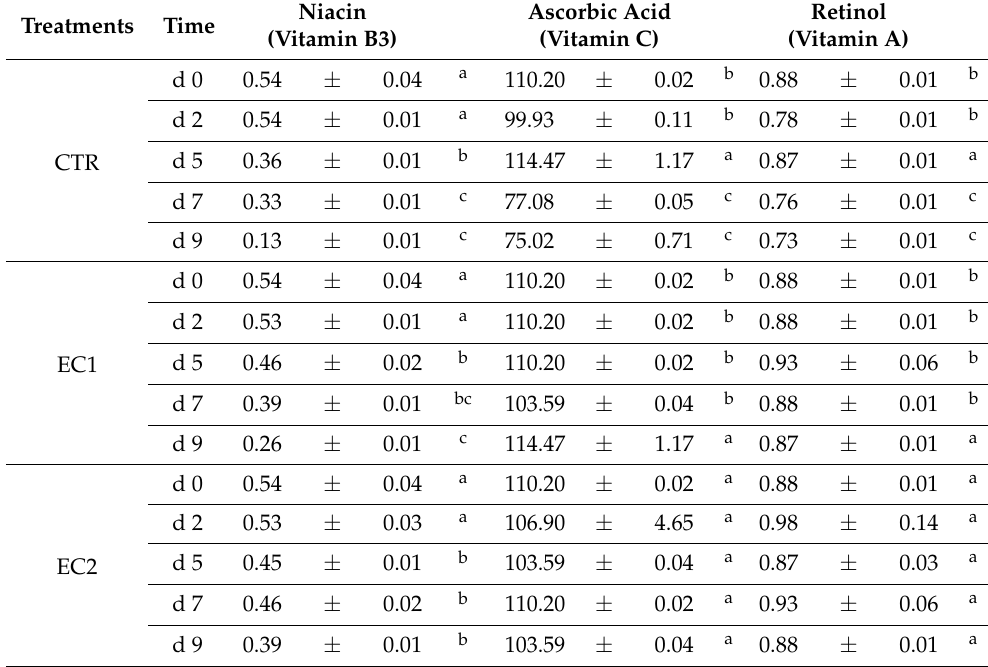
Table 4. Milligrams of vitamins in mango cube